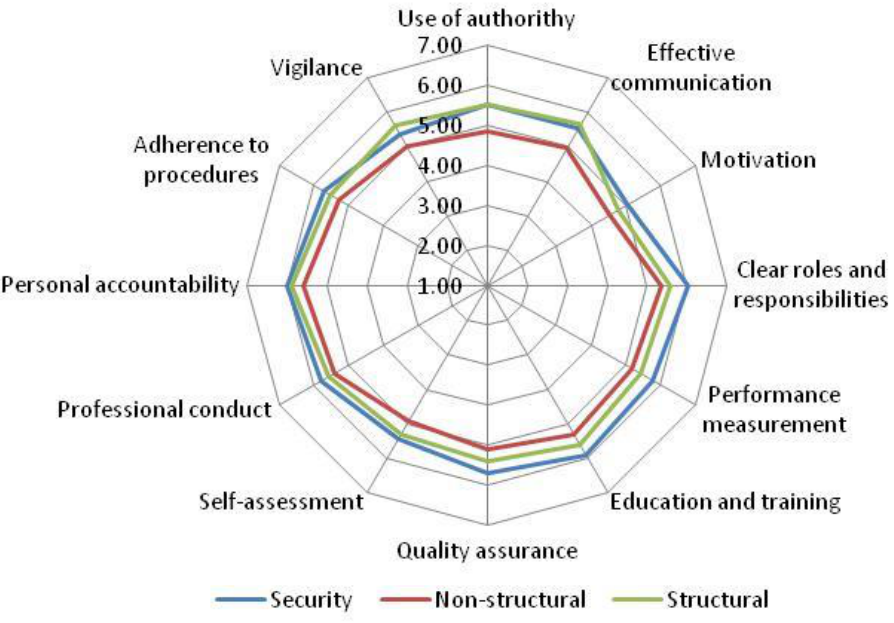
Figure 7. Score of twelve characteristics surveyed for three different